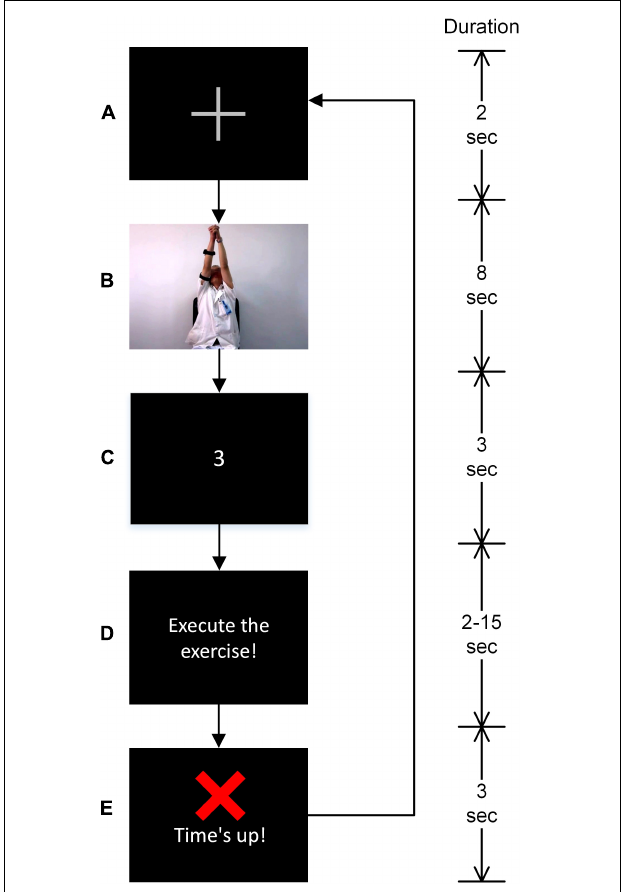
FIGURE 1 | Description of the task’s trial and visual stimuli. Instructions were delivered in the following order. (A) A fixation cross marking the start of the trial, (B) exercise video, (C) a 3-2-1 timer, (D) image depicting instruction to start performing the exercise. The time given to perform the exercise